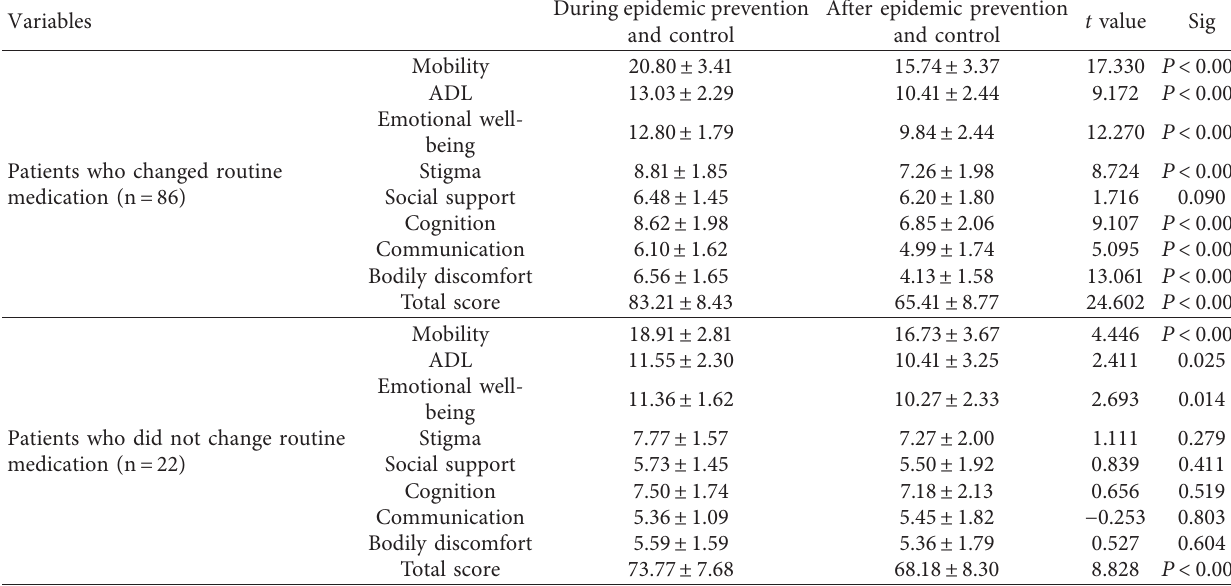
Table 4: Comparison of PDQ-39 outcomes between during and after epidemic prevention and control in patients who changed routine medication and those who did not.